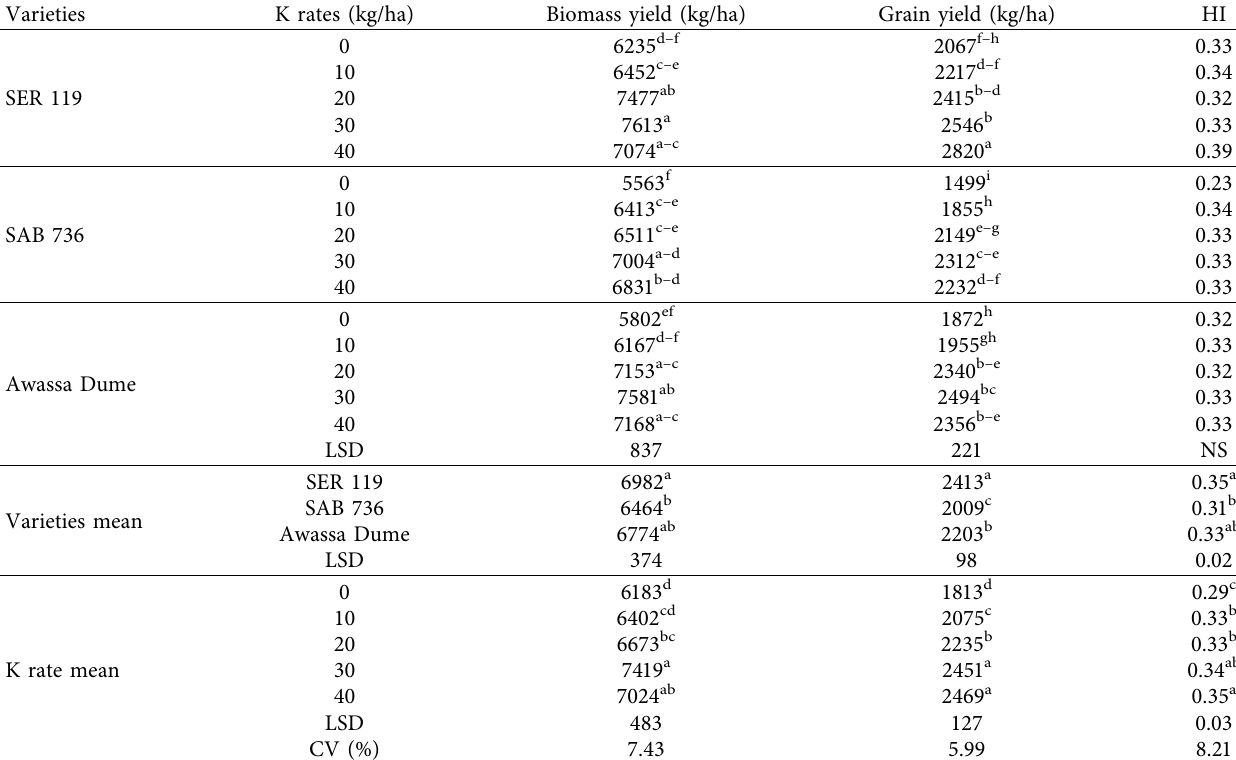
Table 4: Biomass, grain yield, and HI as afected by varieties and K rates during 2019/20 cropping seasons. Varieties